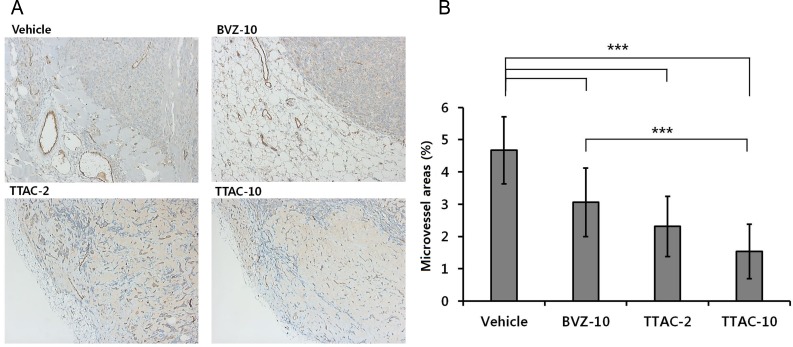
Immunohistochemistry with the anti-CD31 antibody for blood vessel detection.(A) Microscope images (magnification × 200) of the four groups (control, BVZ-10, TTAC-2, TTAC-10). (B) The vessel density in the tumors is shown for each group. Data are presented as mean ± sd in the graphs. ***, P < 0.001; **, P < 0.01; *, P < 0.05. BVZ-10, bevacizumab 10 mg/kg; TTAC-2, TTAC-0001 2 mg/kg; TTAC-10, TTAC-0001 10 mg/kg.